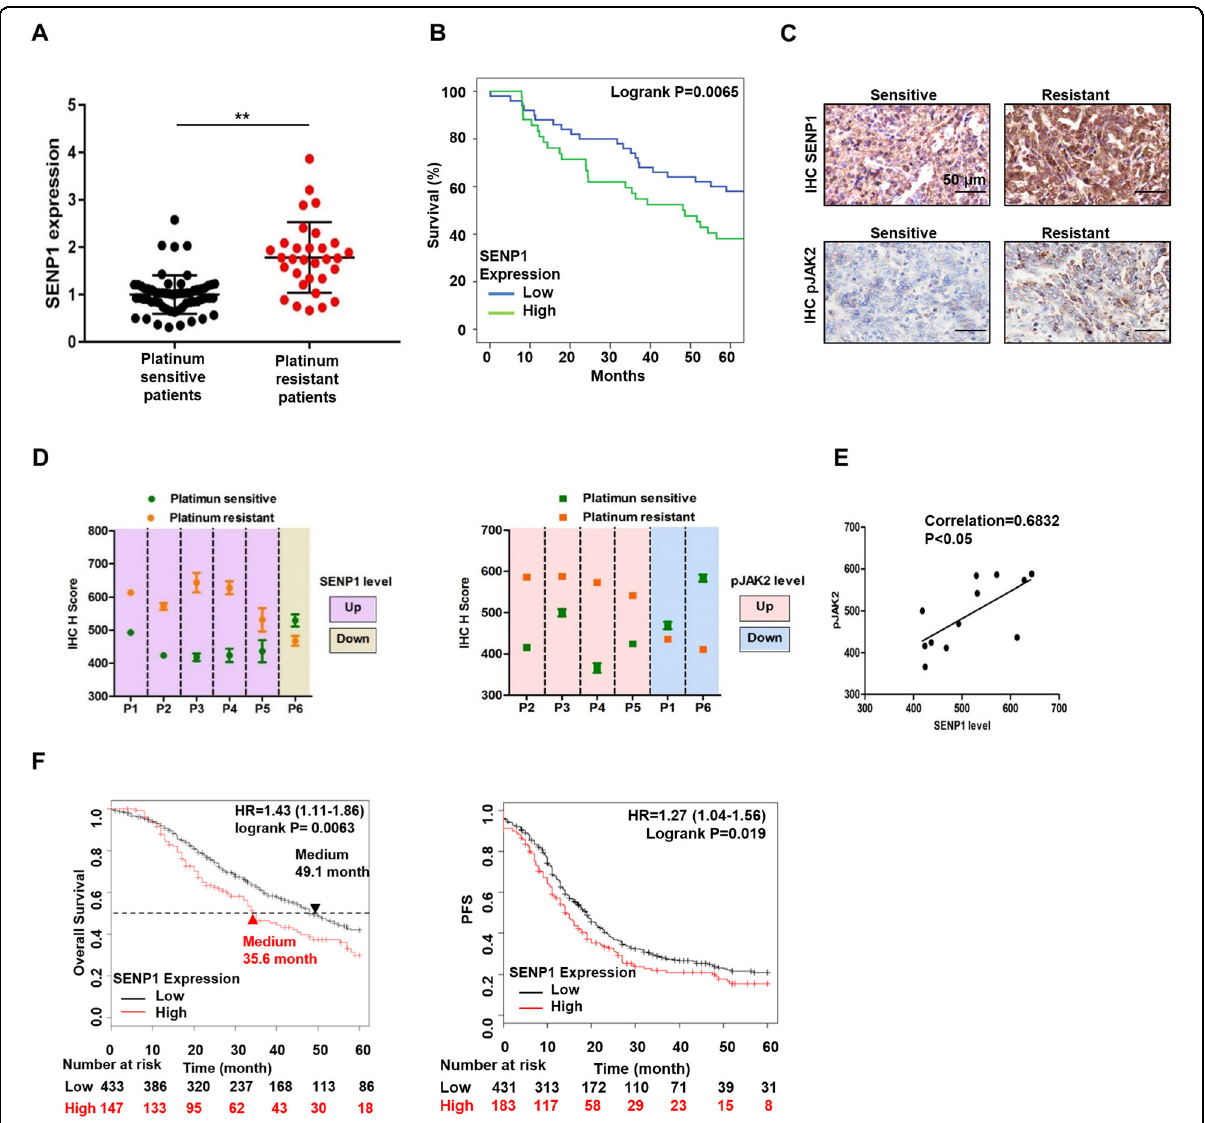
Fig. 6 Clinical evidence of activated SENP1/JAK2 activity in platinum-resistant ovarian cancer patients. A SENP1 mRNA expression level in platinum-sensitive and -resistant ovarian cancer patients. Number of patients evaluated: 61 (platinum-sensitive), 32 (platinum-resistant). mRNA expression levels were assessed by qPCR. **, p < 0.01. B Kaplan – Meier analyses of 5-year overall survival rates of patients as shown in ( A ). C Representative SENP1 IHC staining from the same patient before and after development of chemoresistance. D Quanti fi cation of IHC scores from 6 patients. Left, SENP1 IHC, Right, phosphorylated JAK2. Data are represented as mean ± SD. E Correlation of IHC scores between SENP1 and pJAK2 expression in samples from six patients. F Kaplan – Meier analyses of 5-year overall survival rates (left), and progression-free survival rates (right) based on clinical and molecular data from ovarian cancer patients (OS: n = 1581; PFS: n = 1435) 29 . Patients were strati fi ed by SENP1 mRNA expression in their tumors. Medium survival, log-rank (Mantel-Cox) p values and hazard ratios (HR). 95% con fi dence interval in parentheses were